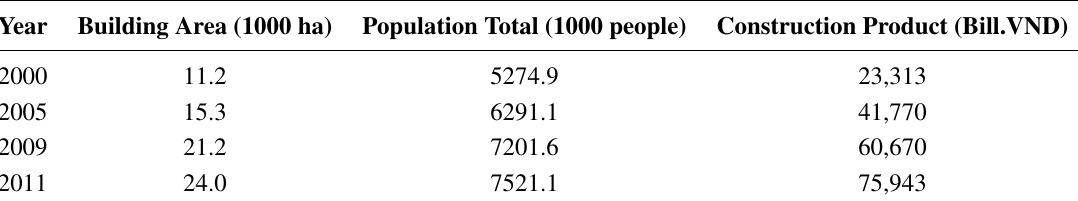
Table 1. Urban building area, population and industry product in Ho Chi Minh City [19].